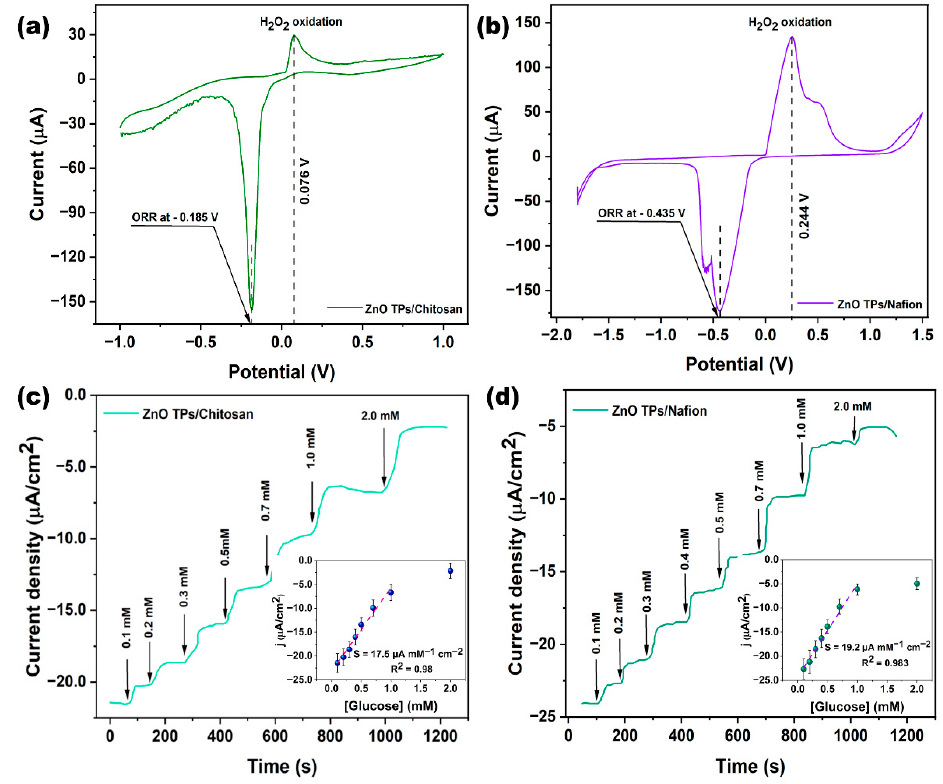
Figure 5. CV curves of ZnO TPs/chitosan ( a ) and ZnO TPs/Nafion ( b ) measured in PBS solution consisting of 0.3 mM of glucose. Glucose detection performances on ZnO TPs/chitosan ( c ) and ZnO TPs/Nafion electrodes ( d ). Measurements were carried out in electrochemical cell at applied potential − 0.185 V for the ZnO TPs/chitosan electrode, and at − 0.435 V for the ZnO TPs/Nafion electrode.